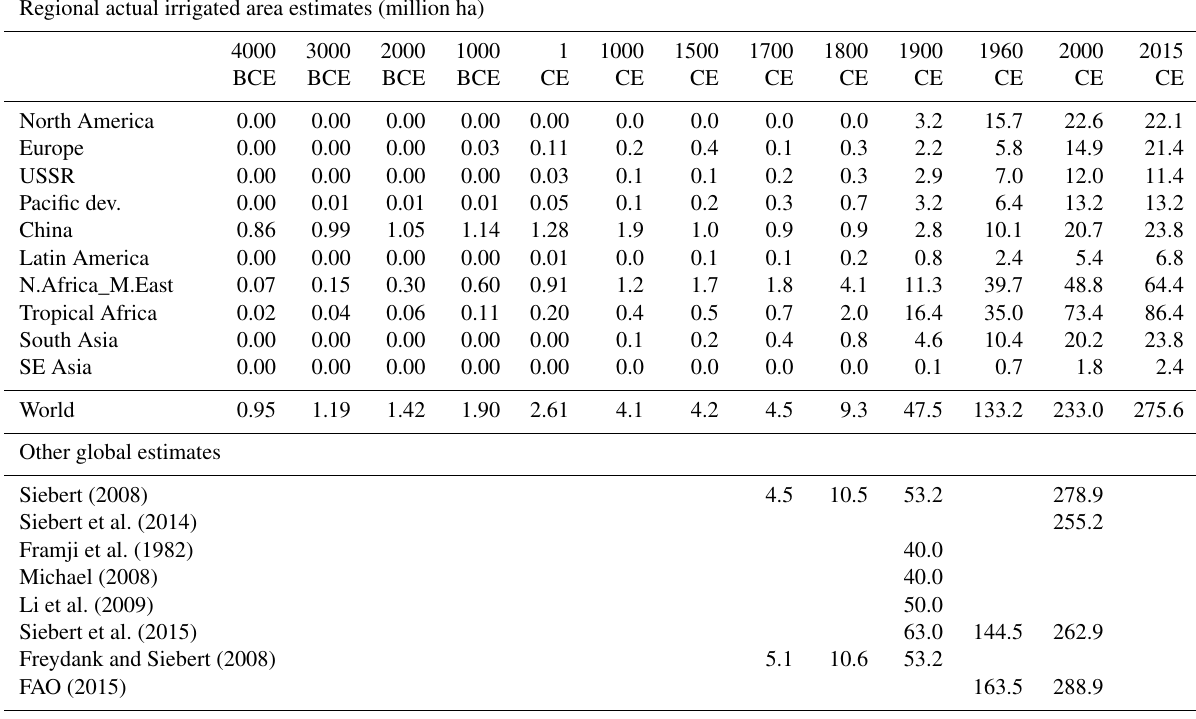
Table 3. Regional irrigated area estimates (million ha). Regional actual irrigated area estimates (million